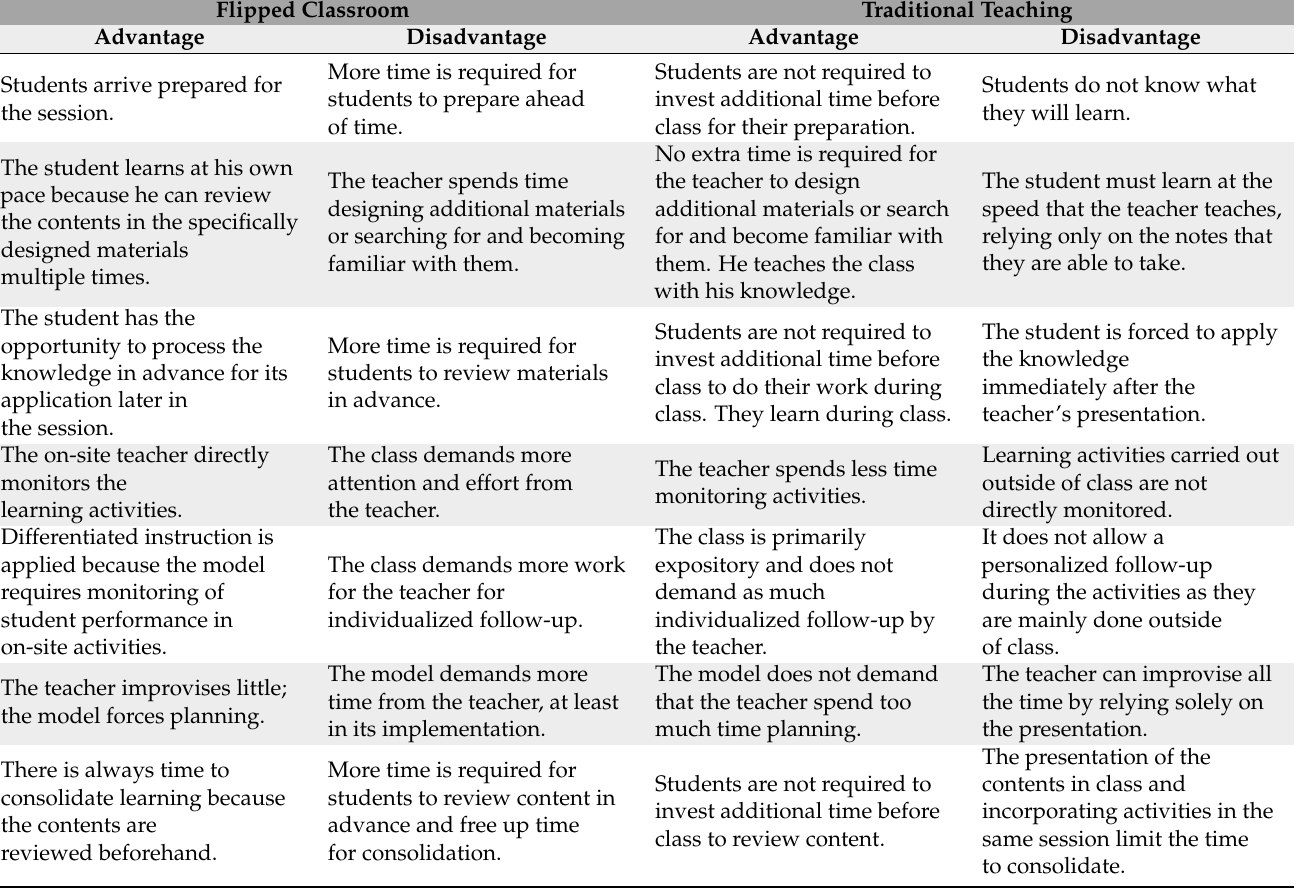
Table 1. Advantages and disadvantages of the Flipped Classroom model and traditional